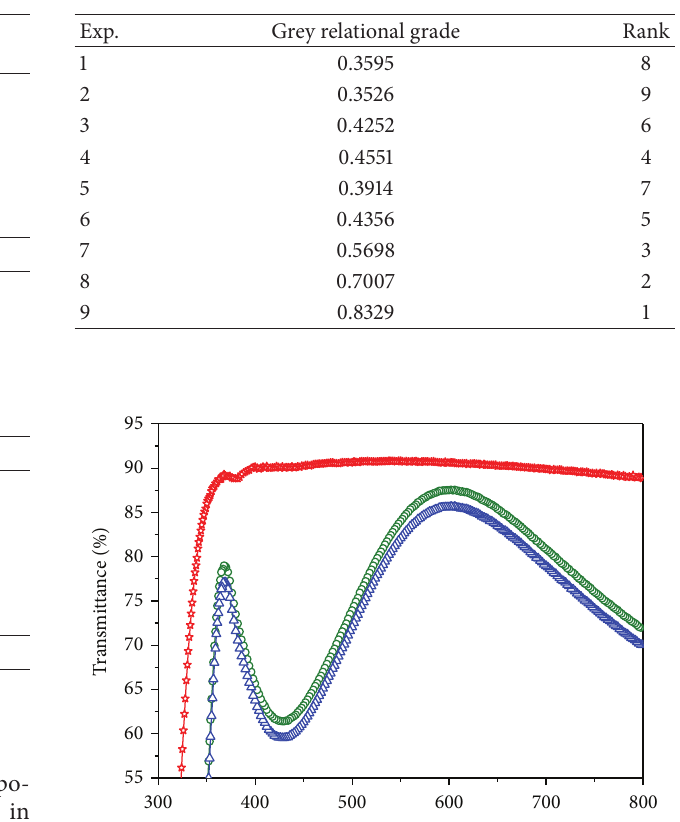
Table 3: The ANOVA results for the deposition rate, the water contact angle, and the MB absorbance.